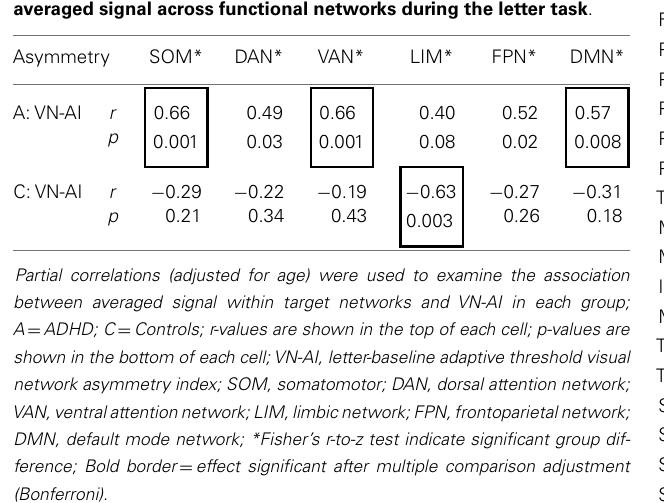
Table shows ADHD positive associations between visual network asymmetry (VN-AI) and extra-visual-network brain regions during the letter task. A > C indi- cates significantly greater positive association in ADHD versus controls. Results are ordered along anterior-to-posterior axis; Hem., hemisphere; L, left hemi- sphere; R, right hemisphere; Mid, activated voxel with x-coordinate between − 5 and 5; MNI, Montreal Neurological Institute structural atlas coordinates (x-, y-, and z-axis); Z-val., z-value indicating BOLD signal intensity at reported voxel; Significance determined using a voxelwise threshold of z = 2.3 and a cluster size probability of p <